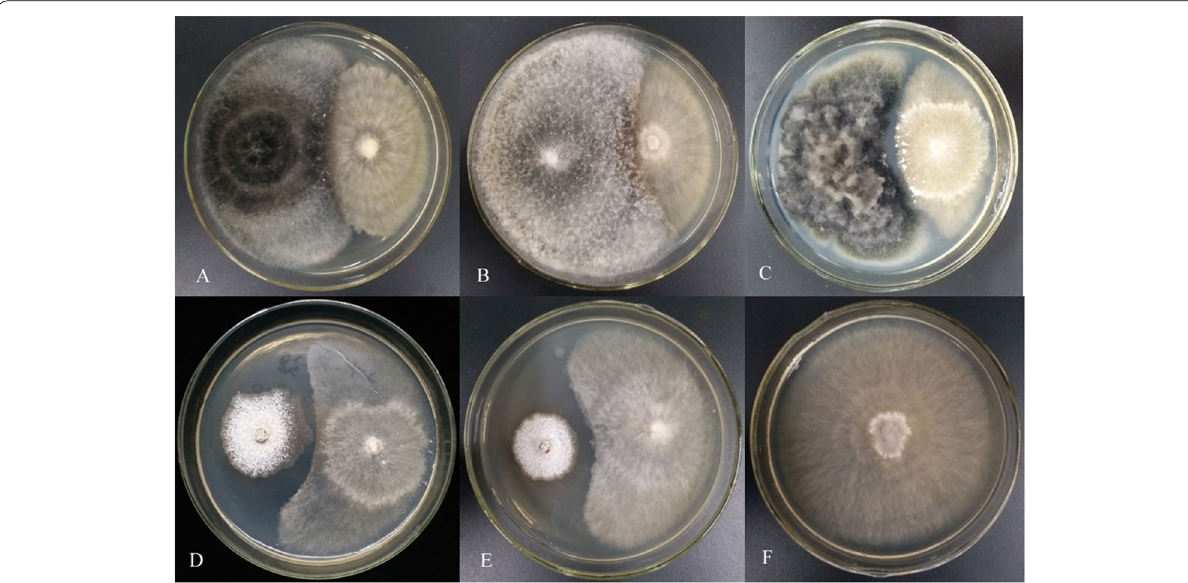
Fig. 1 Antagonism of representative strains on Rhizoctonia cerealis after 5 days of confrontation culture. A – E Strains S2-12, S2-33, S3-01, R-05, and R-03 in order, wherein A and B were matrix competition, C – E was antibiosis, and F is a control, wheat sheath